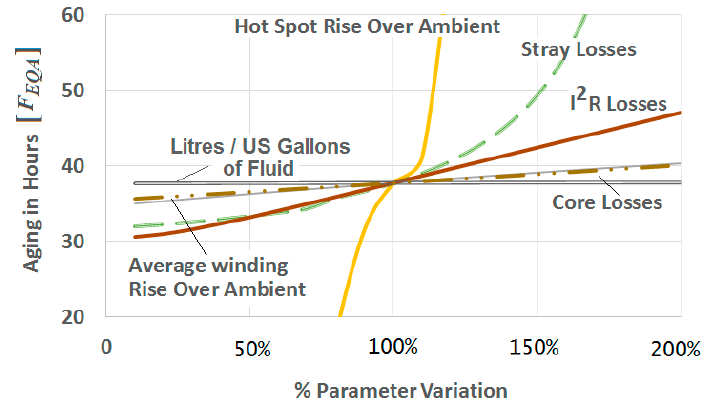
Figure 6. Aging induced by Profile A on the 50 MVA SPX unit as a function of design